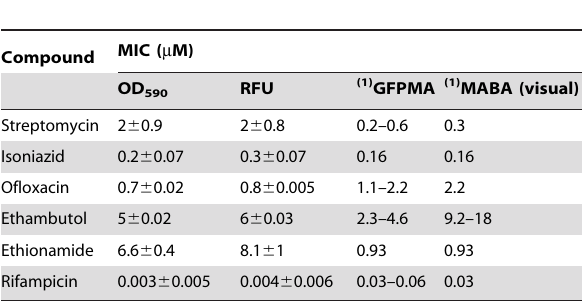
Table 2. MIC of known anti-tuberculosis